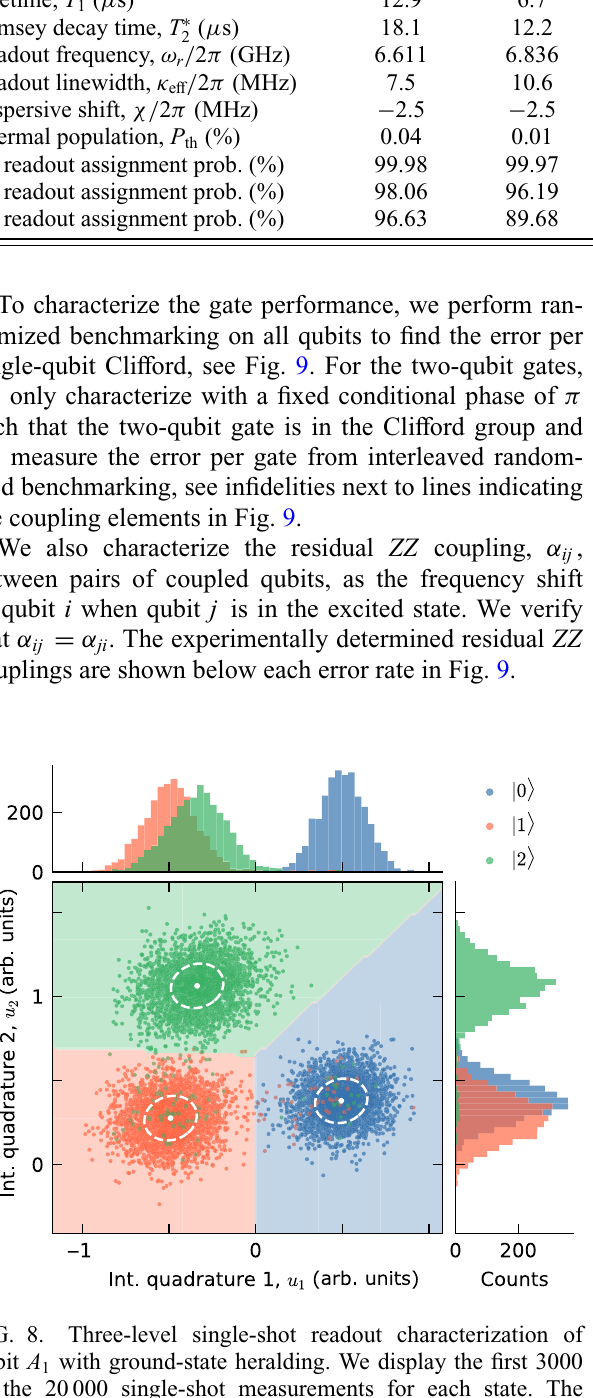
FIG. 9. Single-qubit error per gate (vertices) and two-qubit error per gate (edges) in percent, measured with randomized benchmarking. We indicate the residual ZZ coupling between each pair of coupled qubits below the corresponding two-qubit gate infidelity. The gate between A 3 and B 2 is not needed for the problem instances considered in this work (dashed